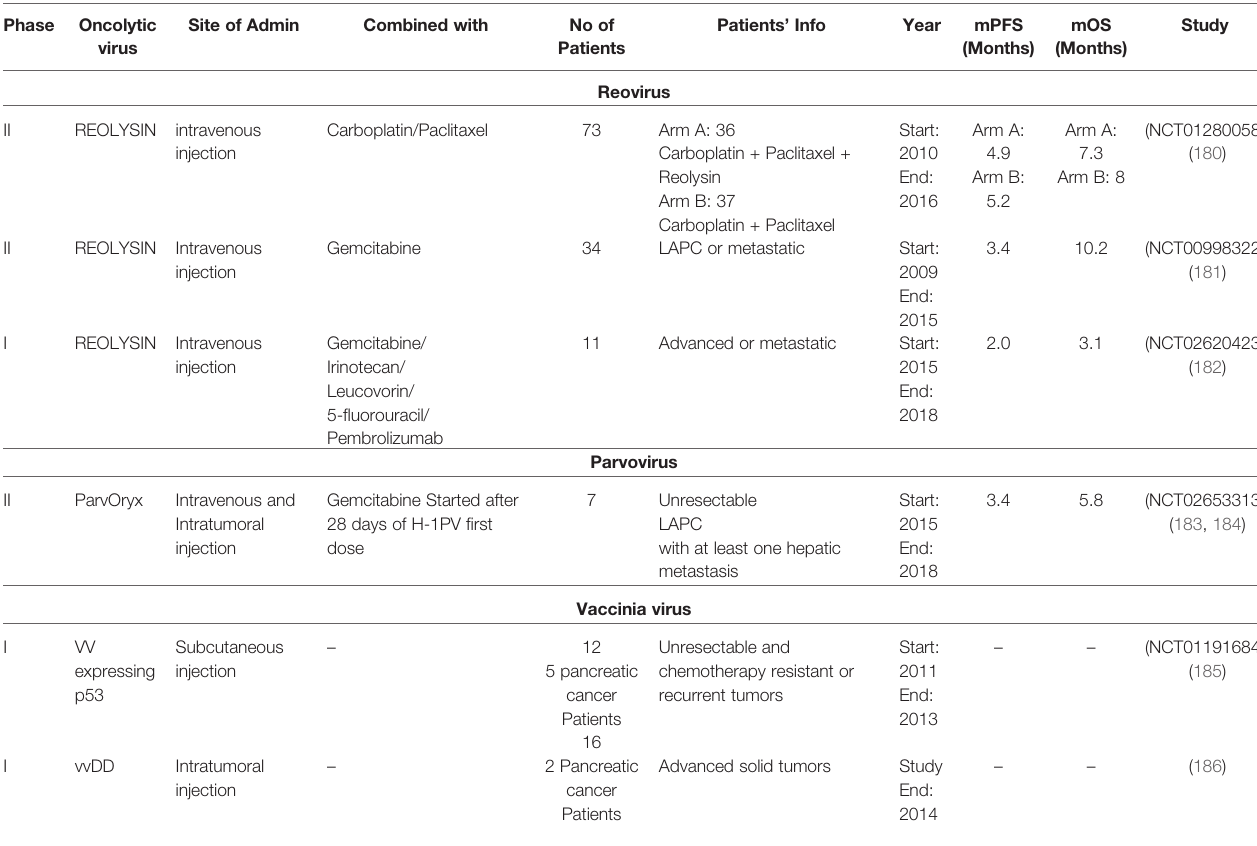
TABLE 2 | Clinical trials for assessing the effect of oncolytic reovirus, parvovirus, and vaccinia virus therapy in patients suffering from pancreatic cancer. Phase Oncolytic